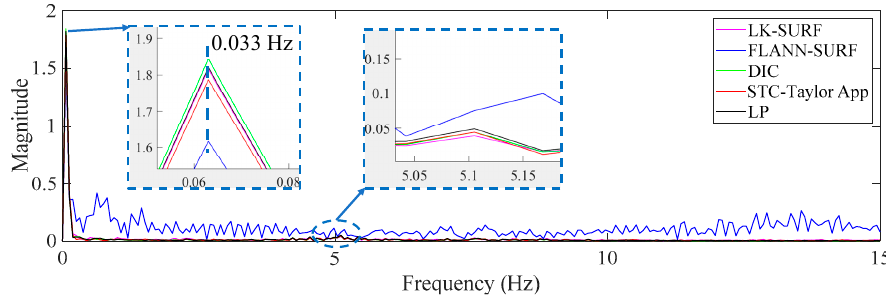
Figure 17. Displacement comparison in the frequency domain of Case 2 (illumination change).